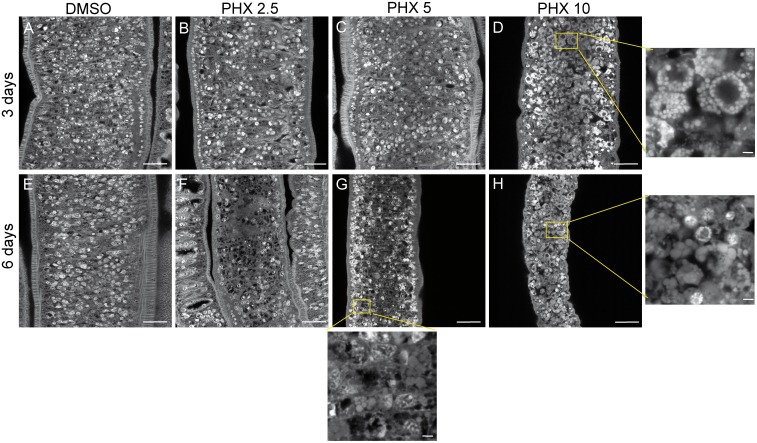
Vitellarium alterations in adult female worms treated with PHX.Representative confocal laser scanning microscope images of the vitellarium of adult female worms. S. mansoni worm couples were treated for 3 and 6 days with DMSO (A, E) or different doses of PHX (B-D, F-H) for 3 and 6 days as indicated and stained with carmine red. Scale bars = 25 μm in the low magnification panels and 2.5 μm in the high magnification insets indicated with yellow boxes.